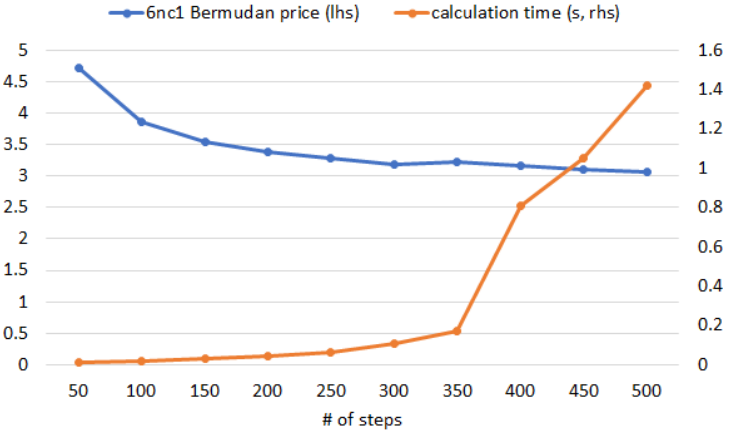
Figure 9. Convergence profile of the Crank-Nicolson scheme implemented for the 6nc1 Bermu- dan swaption.